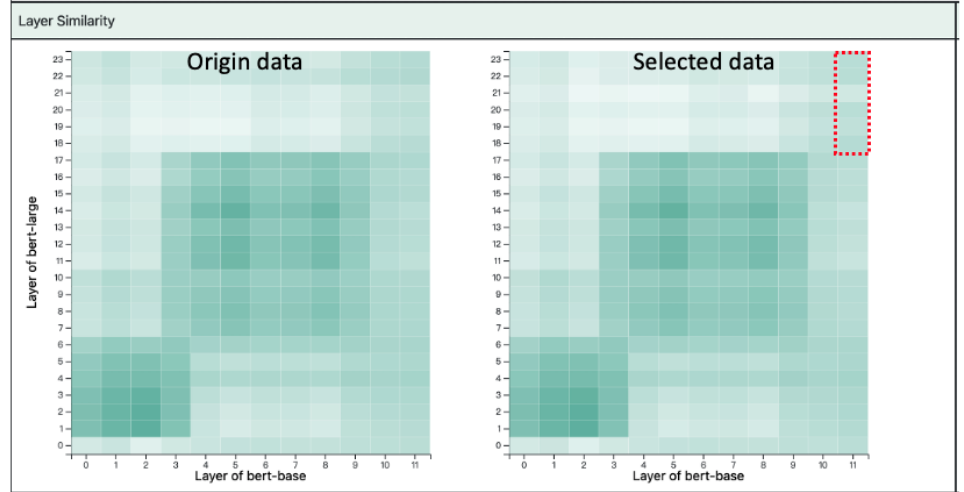
Figure 19. The user checks combinations close to the decision layer and similar to the 11th layer of bert-base